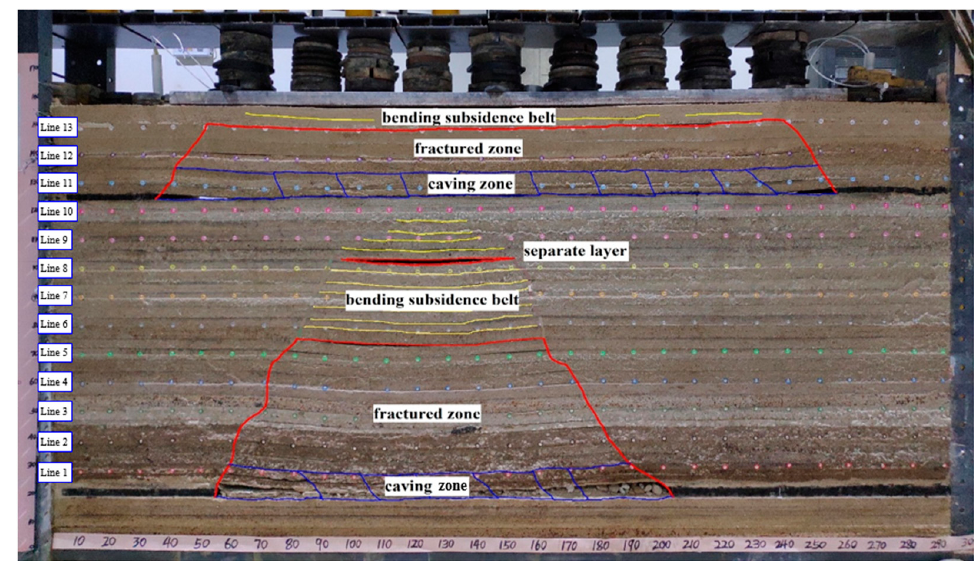
Figure 7. Model overlying strata “three zones” distribution morphology map.